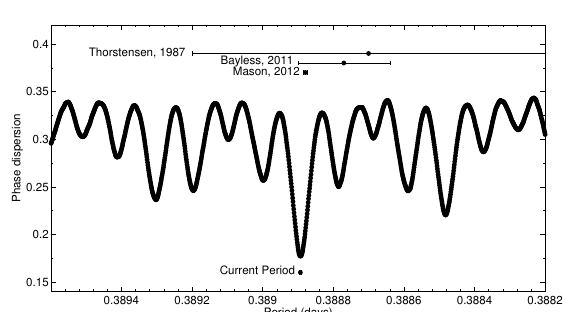
Figure 2: Period search results using phase disper- sion minimization. Previously published results are also shown.